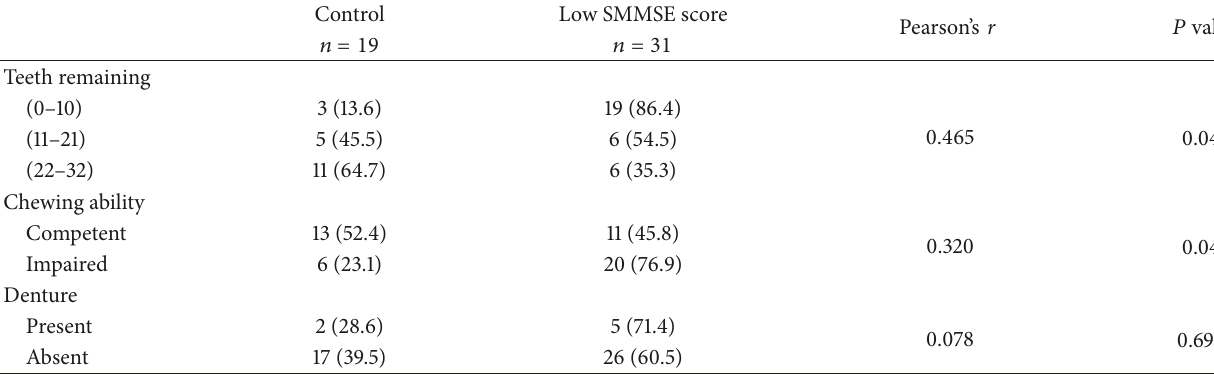
Table 2: Summary statistics of oral health variables and SMMSE scores.